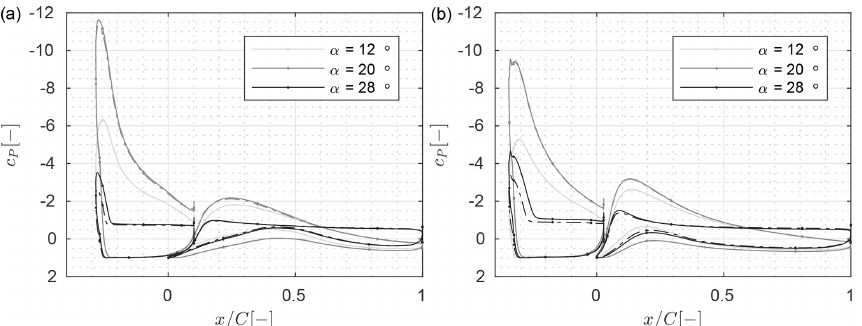
Figure 15. Pressure distribution from CFD for the clean ( − ) and the rough ( − . ) profiles at different angles of attack for (a) configuration A and (b) configuration A ∗ .